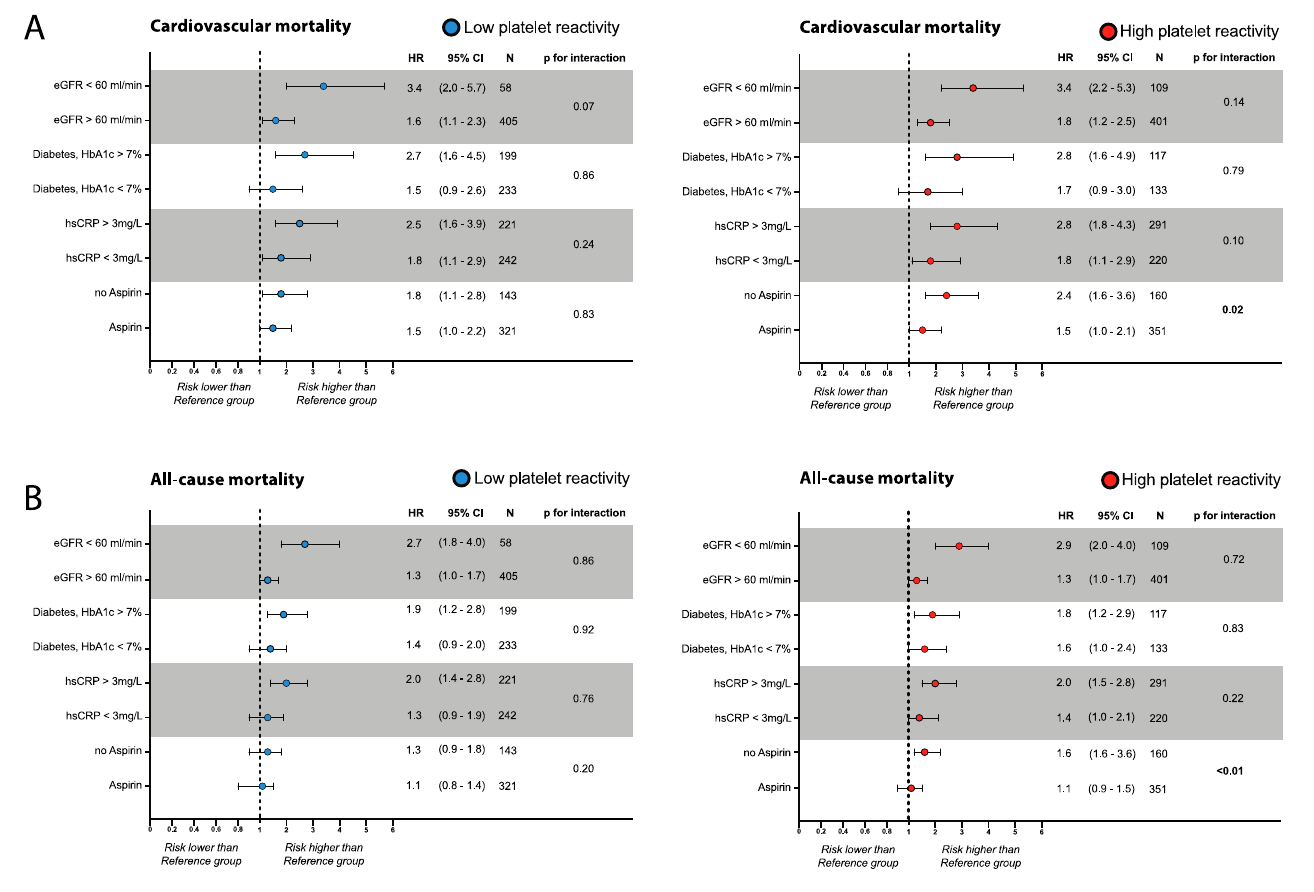
Figure 4. Risk factor-stratified hazard ratios for cardiovascular and all-cause mortality among patients with altered platelet reactivity and the reference group. Forest plot for cardiovascular ( A ) and all-cause mortality ( B ) based on key risk factors/therapies identified by relative weight analysis. Patients with High-(red dot, 511 patients) and Low-(blue dot, 464 patients) platelet reactivity were stratified according to the presence or absence of the appropriate factor. Risk was compared to the risk of the Reference group (545 patients). Continuous variables were a priori categorized based on available guidelines or previous studies (i.e., hs-CRP). The cardiovascular mortality risk in each group was compared to the reference group in the absence of the factor of interest/presence of the therapy of interest. Models were adjusted for age and sex similar to model 1 in Figure